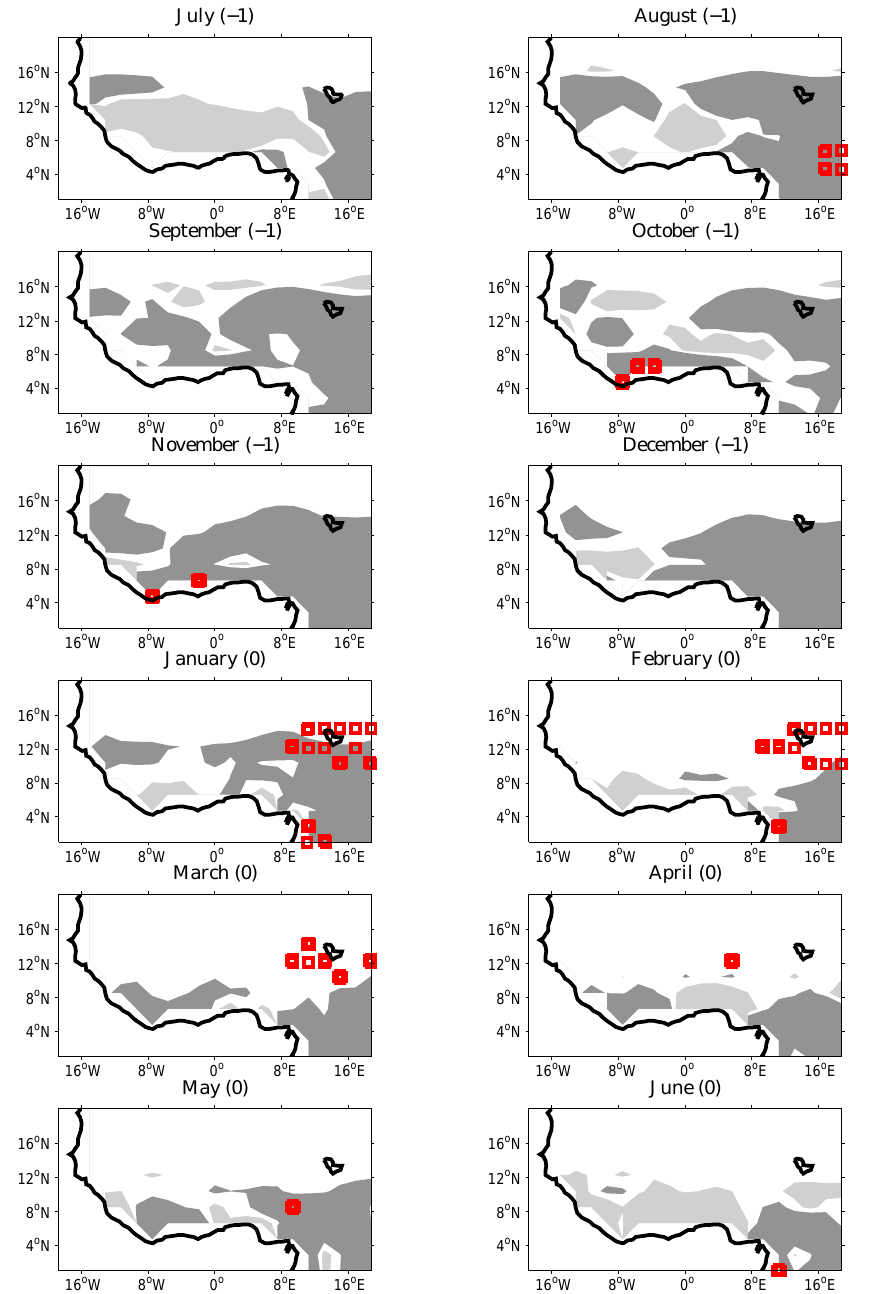
Fig. 5. Monthly composite maps of volumetric deep soil wetness with respect to wet minus dry years (JAS 0) in the Sahel, from July − 1 (top left corner), to June 0 (bottom right corner). Positive (negative) differences exceeding an absolute value of 0 . 125 ∗ 10 − 2 are displayed in dark (light) shading, these values ranging from − 0.021 to 0.031. The black squares define grid points where differences in means are significant at the 95% confidence level from a Student t-test. Data source: